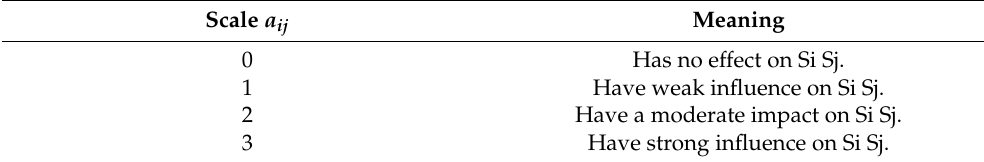
Table 3. Scale and meaning. Scale a ij Meaning 0 Has no effect on Si Sj.